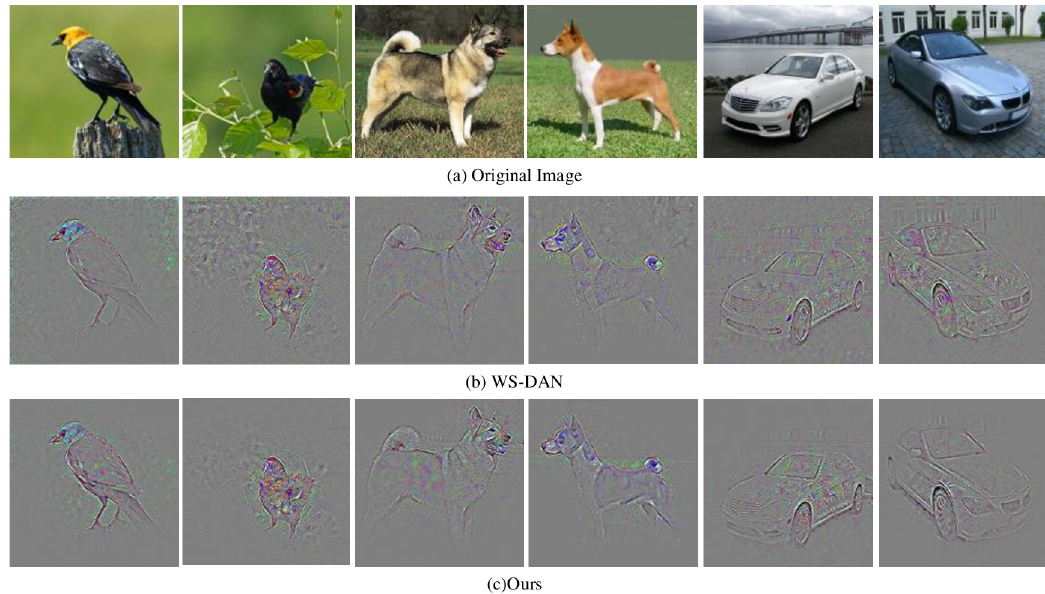
Fig 7. Back propagation saliency map.